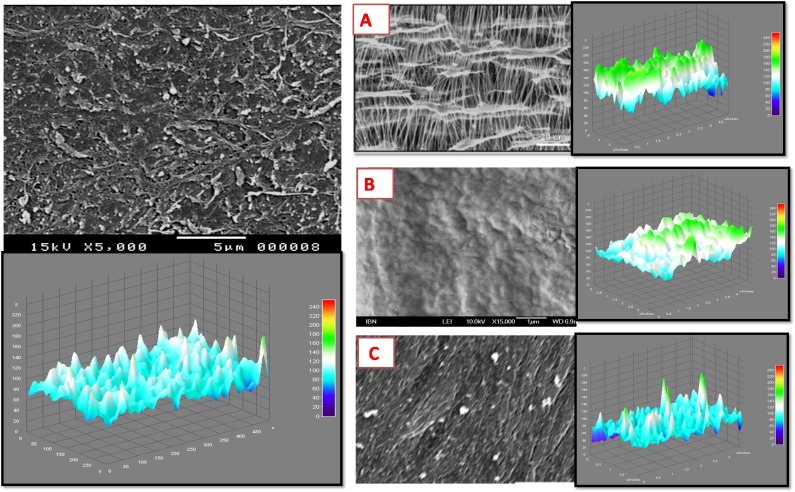
3D Nano-topography of the Decellularized hAM Based Platform.The left panel of this Fig shows a SEM image of the hAM at x5000 magnification. It demonstrates the nano-scale topography of the membrane after decellularization. Below the original SEM image, a 3D- surface plot is obtained by ImageJ which illustrates the peaks and valleys distributed homogenously throughout the surface. On the right panel, 3 examples of synthetic scaffolds are presented along with their corresponding 3D surface plotting using the same ImageJ surface plotting parameters. (A) demonstrates a commercial 3D culture plate coating substrate composed of Polytetrafluoroethylene (PTFE) polymer modified with an amphiphilic polymer and collagen. (B) shows a SEM image of a 3D commercial scaffold (at x15000 magnification) composed of inert hydroxypropyl cellulose to form a sponge like structure. (C) demonstrates a synthetic scaffold fabricated from polypyrrole (PPy) and poly(styrene sulfonate) (PSS) interwoven within a PCL matrix[43]